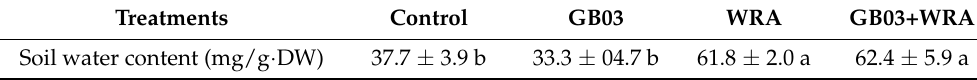
Table 1. Soil water content after 20 days of natural drought. Values are means with SEs ( n = 12). Different letters indicate significant differences among treatments at p < 0.05 (ANOVA and Duncan’s multiple range test).